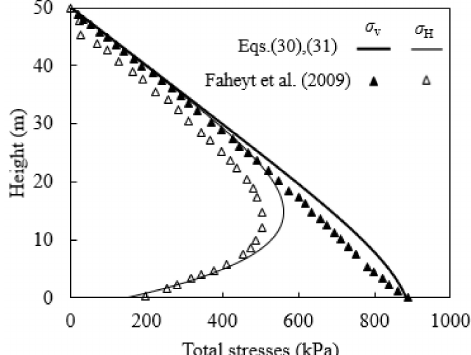
Figure 3. Distribution of the vertical and horizontal total stresses along a vertical profile of 2 m from the vertical center line of the stope at the end of the filling operation, calculated by the proposed solutions (Equations (30) and (31)) with K = K a and obtained by numerical simulation with Plaxis (numerical results taken from Fahey et al.